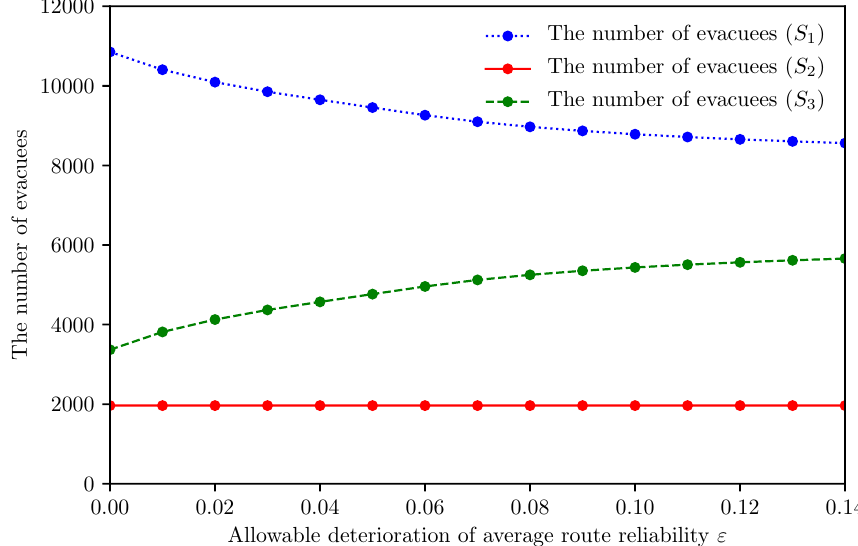
Figure 7. Relationship between ε and the number of allocated evacuees per refuge ( β = 0.7).